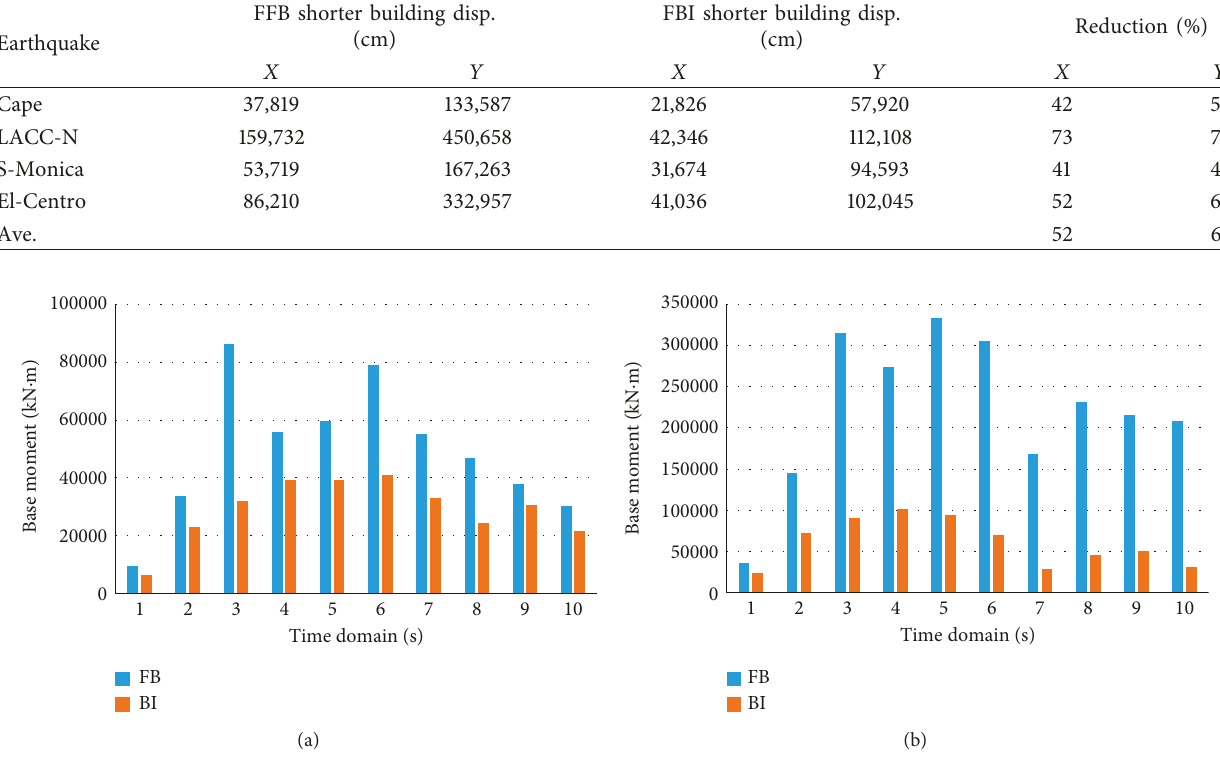
Figure 16: Absolute base moment in FFB and FBI adjacent buildings. (a) Longitudinal direction. (b) Transverse